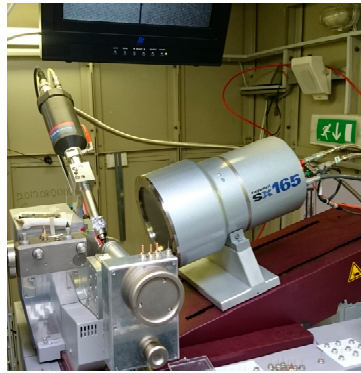
Figure 1. General view of the diffractometer unit at the ‘Belok’ beamline.